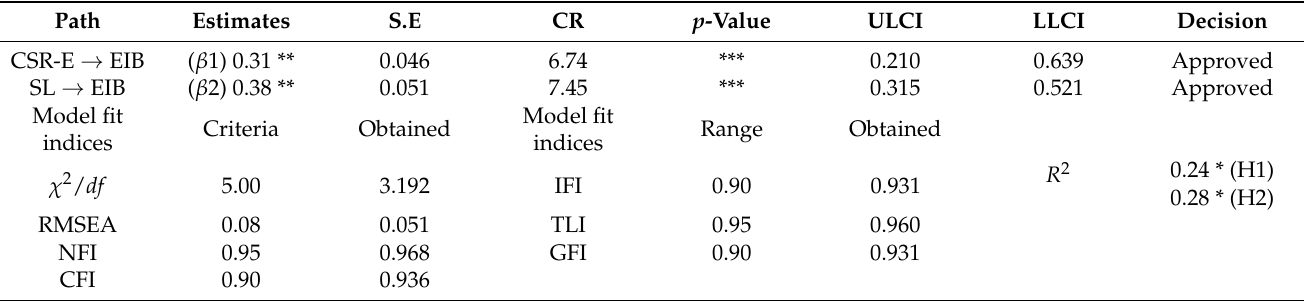
Table 4. The results for Hypotheses (H1) and